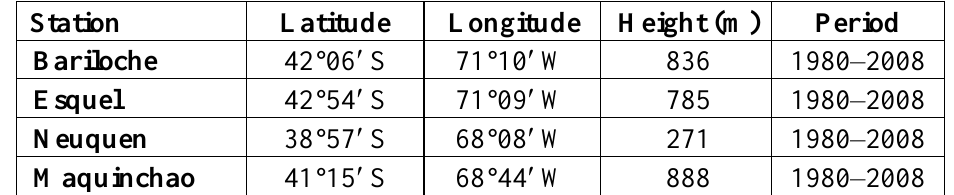
Table 1. Characteristics of the meteorological stations used for the temperature analysis.